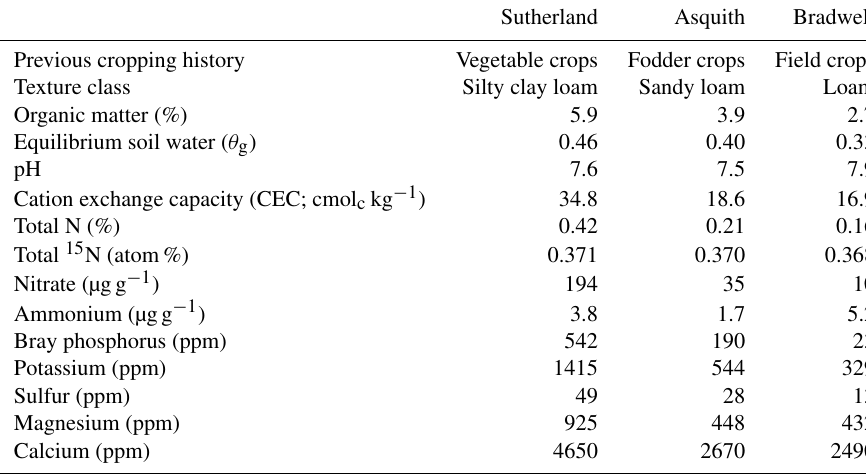
Table 1. Soil physical and chemical